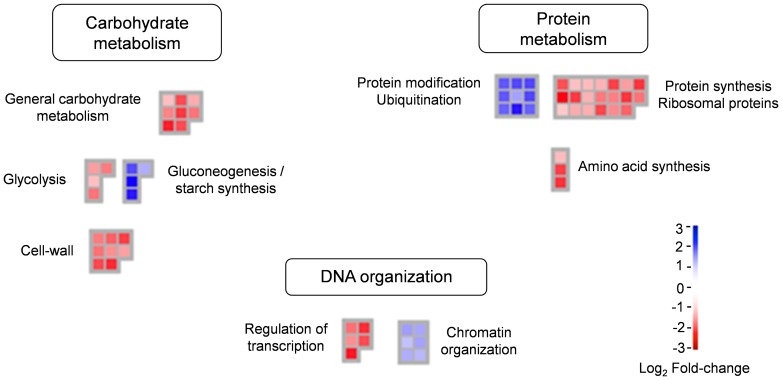
Mapman based representation of biological function categories enriched in genes differentially expressed in MON810 versus near-isogenic immature embryos.Each gene is represented as a box; red boxes indicate genes down-regulated in the MON810 variety and blue boxes correspond to genes up-regulated in DKC6575 in a log2 scale of +3 to -3.